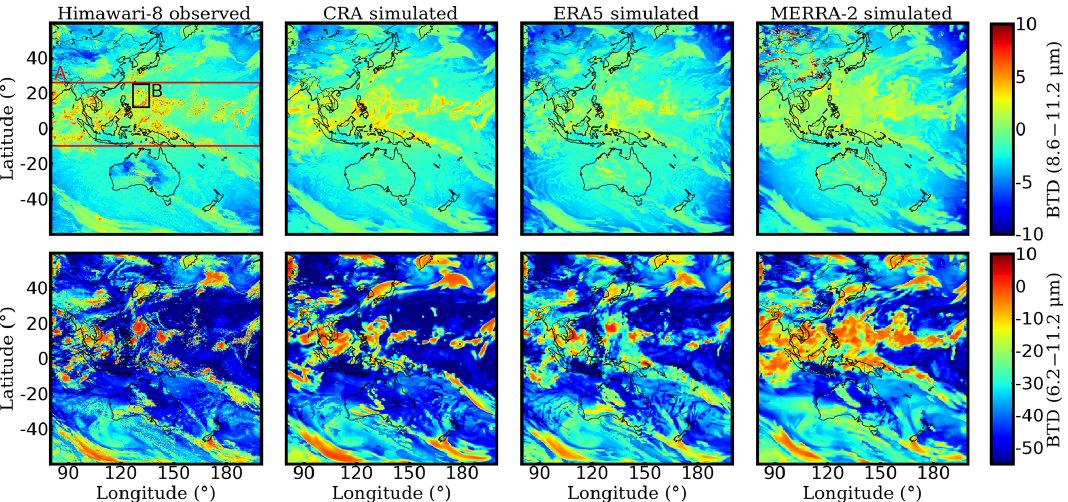
Figure 8. Observed and simulated brightness temperature differences of 8.6–11.2µm (top) and 6.2–11.2µm (bottom). The results are taken at the same time as that in Fig.